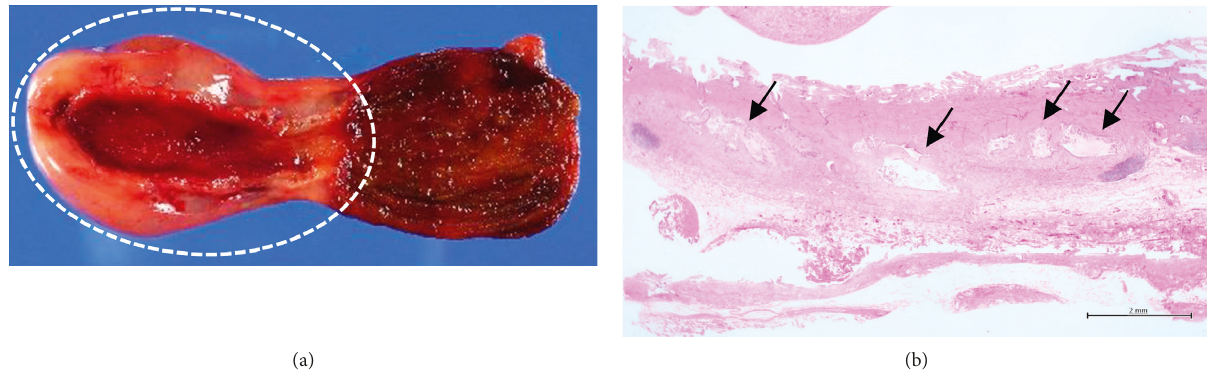
Figure 4: (a) More than half of the distal wall of the gallbladder was thickened (circle). (b) A histopathological examination revealed that the thickened wall contained Rokitansky–Aschoff sinuses (arrows) combined with hyperplasia of the smooth muscle and collagen fibers, which were compatible with adenomyomatosis of the gallbladder. Table 1: The clinical features of eleven pediatric cases with adenomyomatosis of the gallbladder reported in the literature including our case. Case Year First